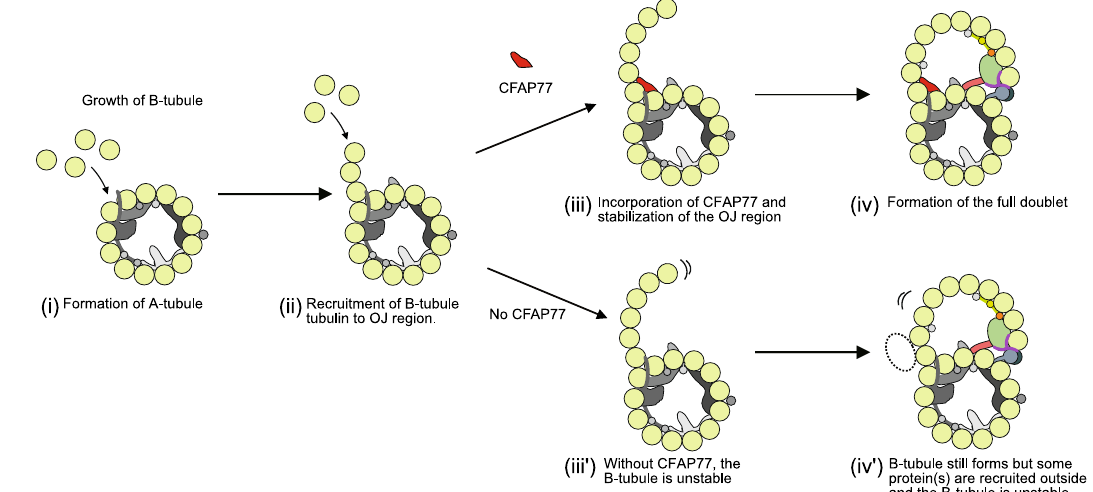
Fig. 7 | A model of the role of CFAP77 on the formation of the B-tubule. The A-tubuleisformed(i),thenfreetubulinsbindtoformthehookattheouterjunction (OJ) region (ii). With CFAP77, the newly formed B-tubule hook is stabilized (iii), leading to the fi nal DMT formation (iv). Without CFAP77, the B-tubule is